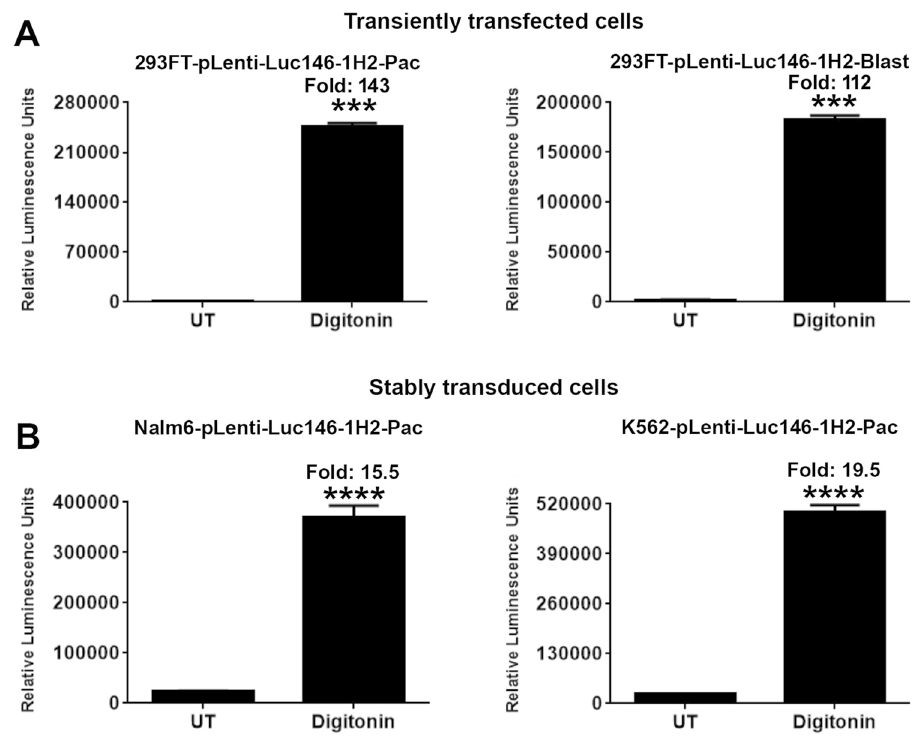
Figure 1. Validation of Matador-Glo assay using transiently transfected and stably transduced cells. ( A ) The indicated Luc146-1H2 lentiviral vectors were transiently transfected in 293FT cells. Approximately, 24 h post-transfection cells were treated with digitonin (30 µg/ml) for 90 min or left untreated (UT). Cell-free supernatants (25 µl) were assayed for luminescence by adding D-luciferin containing assay buffer (25 µl) directly to each well in a 384-well lumitrac plate. ( B ) Indicated cell lines stably expressing Luc146-1H2 were plated in a 384-well lumitrac plate and treated with digitonin (30 µg/ml) for 90 min or left untreated (UT). Luminescence was detected as described for ( A ) . The values shown are mean ± SE of a representative experiment performed in duplicate. Statistically significant differences are shown by asterisks (***) at a level of P < 0.001 and (****) at a level of P <